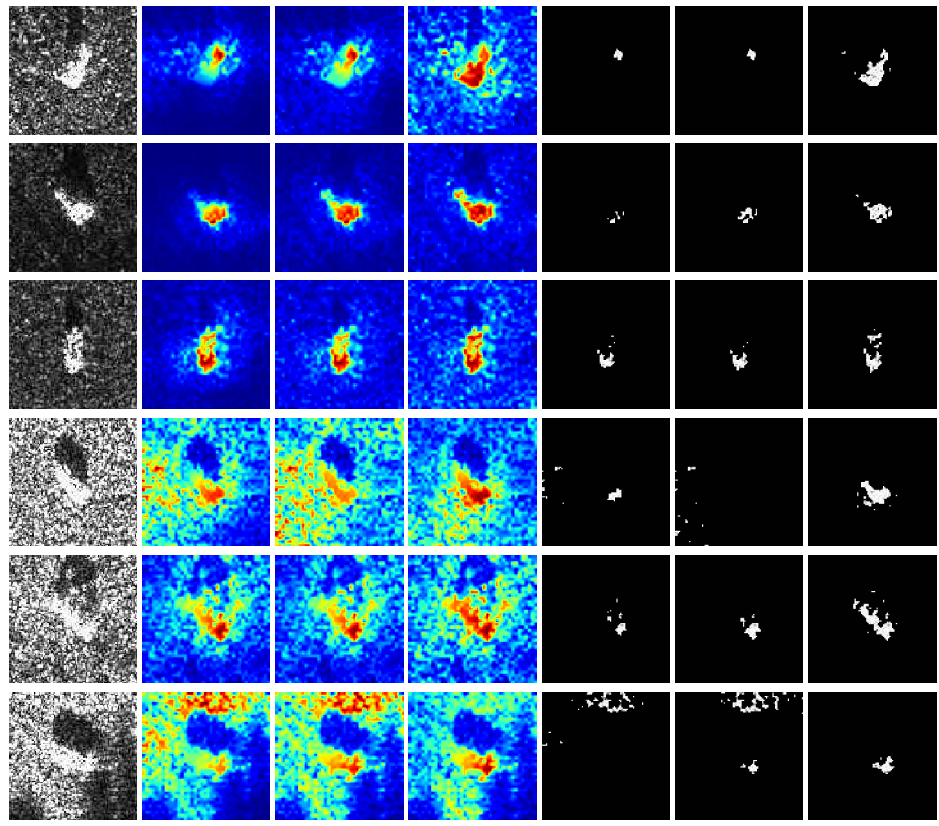
Figure 4. Saliency heatmaps of Self-Matching CAM, G-SM CAM, and SC-SM CAM. The first column shows original SAR images. The second to the fourth columns show saliency heatmaps generated by Self-Matching CAM, G-SM CAM, and SC-SM CAM. The fifth to the seventh columns show corresponding masked